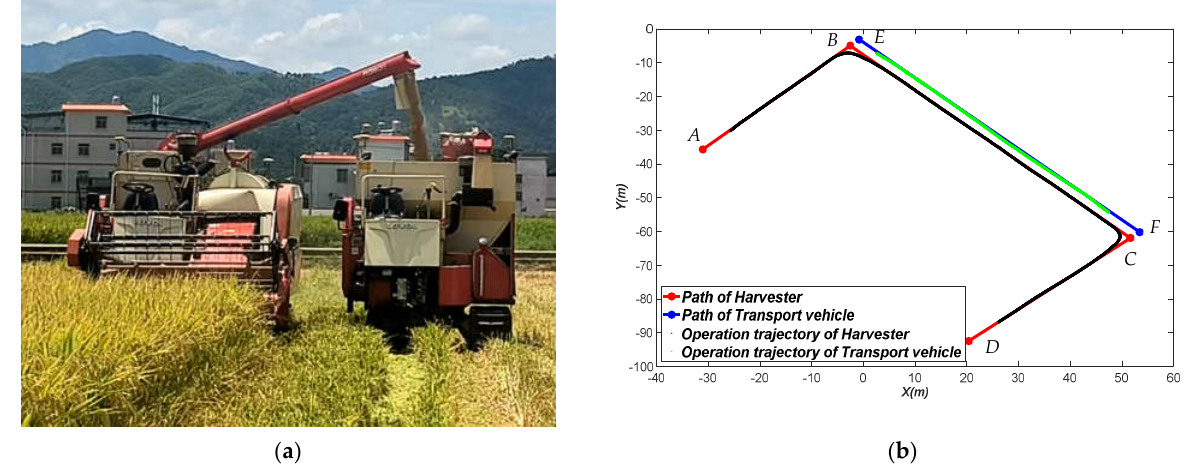
Figure 8. ( a ) Field work scene of collaborative harvesting and unloading; ( b ) the path plan and operation trajectories of harvester and transport vehicle.